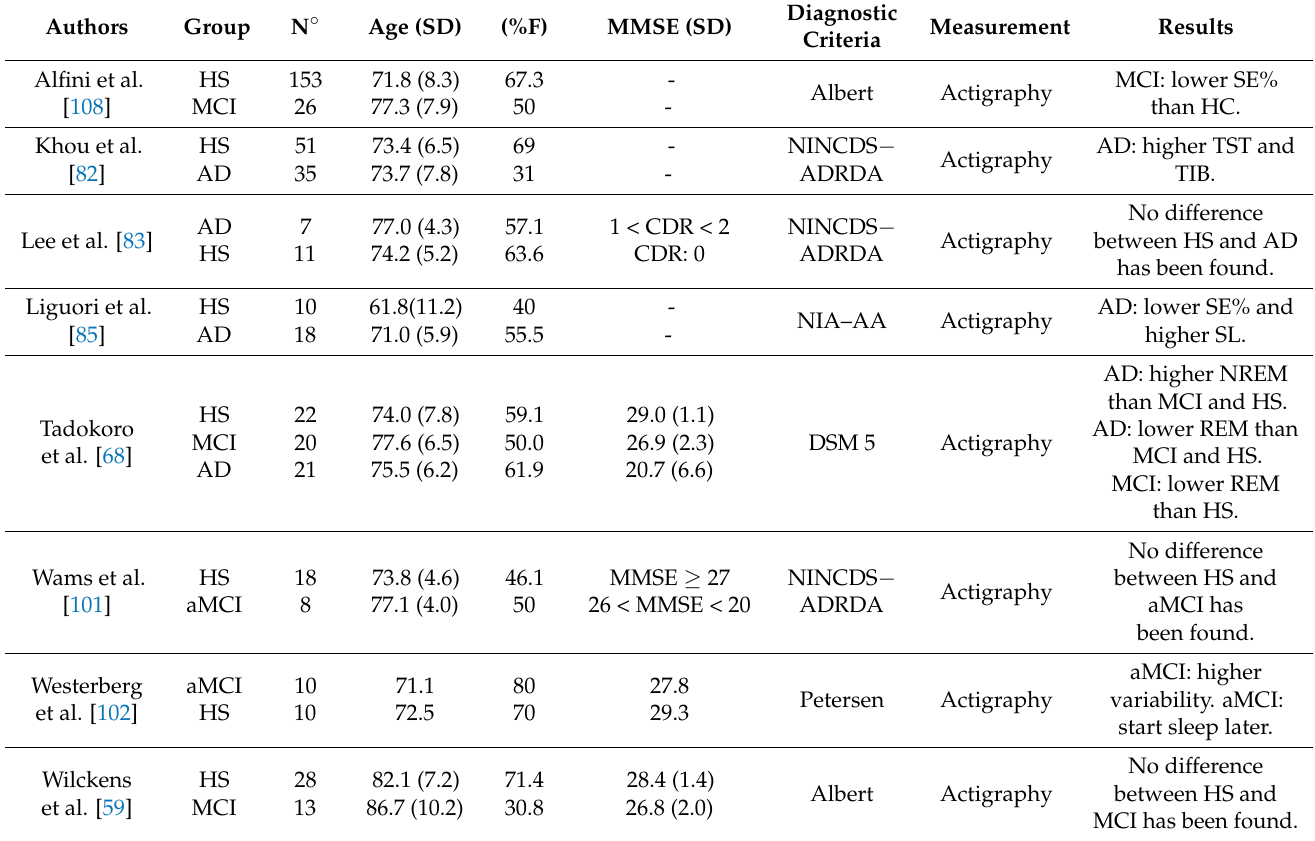
Table 7. Sleep in pathological older age. Summary of all the studies that use